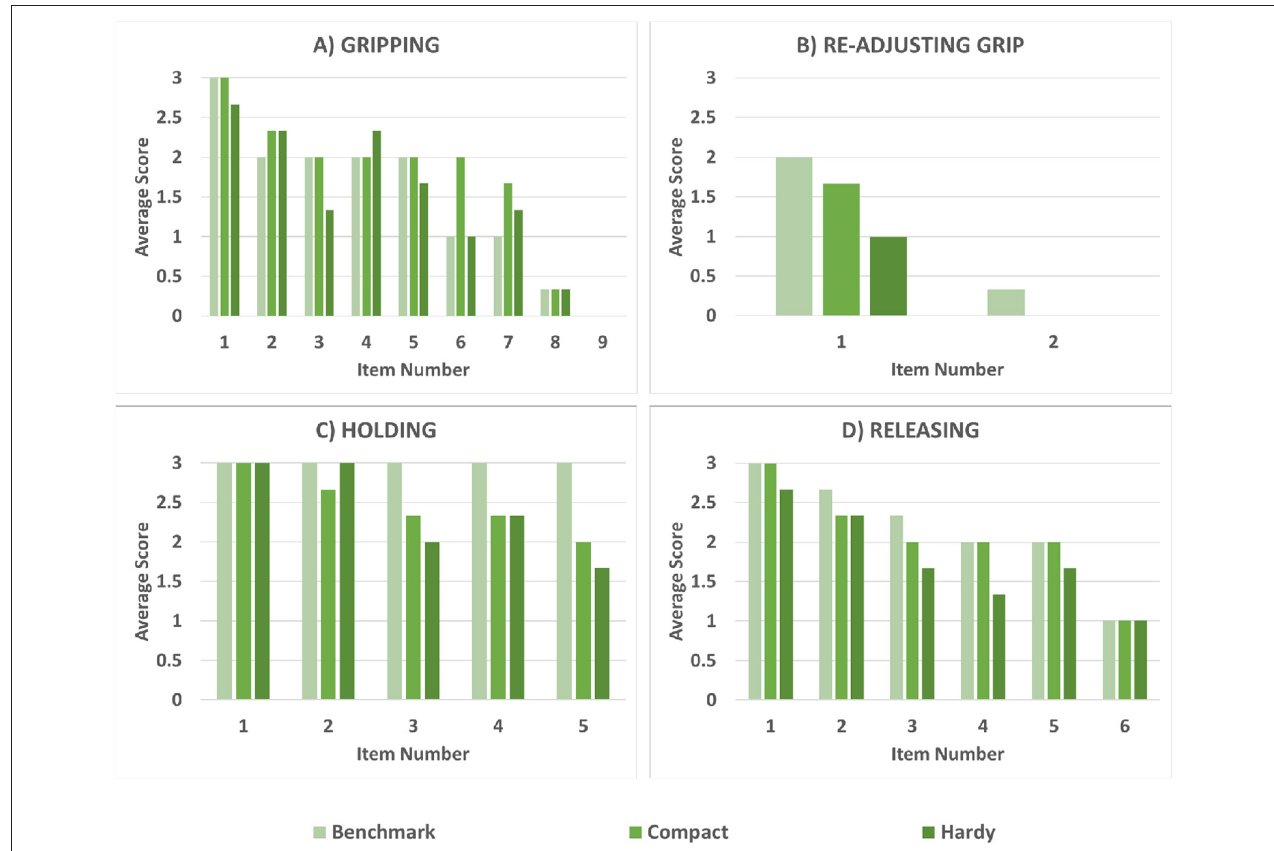
FIGURE 8 | Average results of the three tested configurations for each ACMC item. The full list of items is reported in Table 8